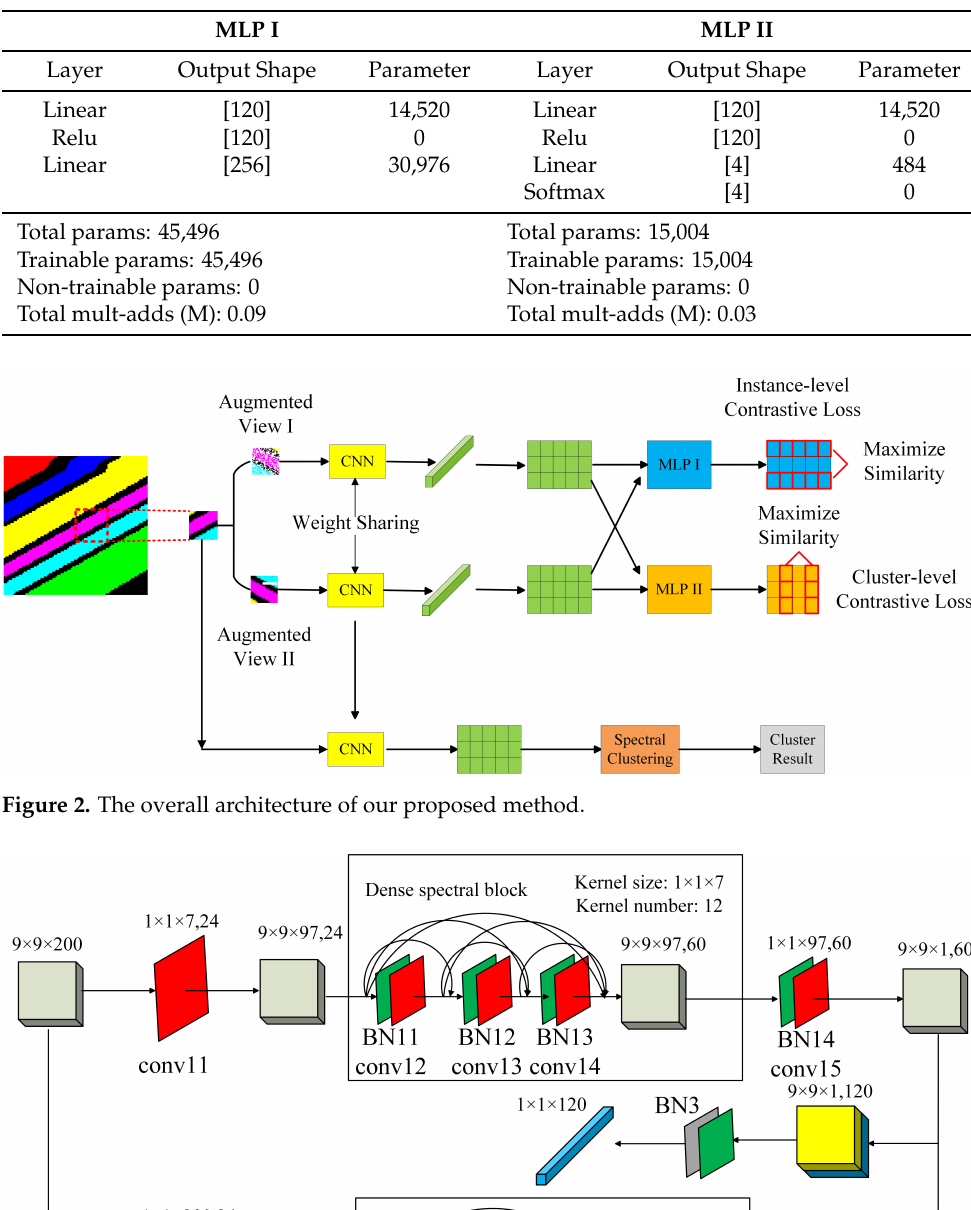
Table 2. Parameters of the two MLPs.